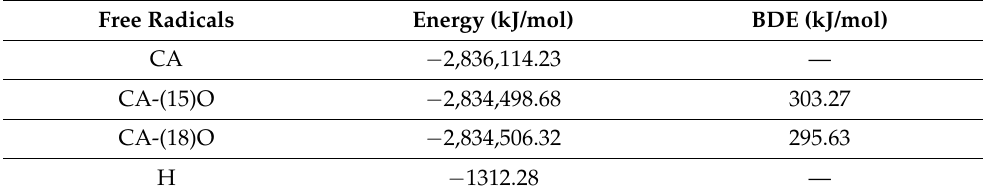
Table 1. BDE of CA molecular and its free radicals (—not given).